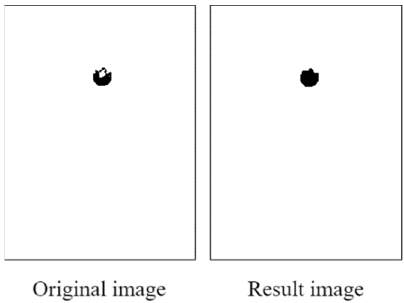
Figure 41. Pixel coordinate image obtained with the PRSSM-based pupil diameter analysis mod- ule.